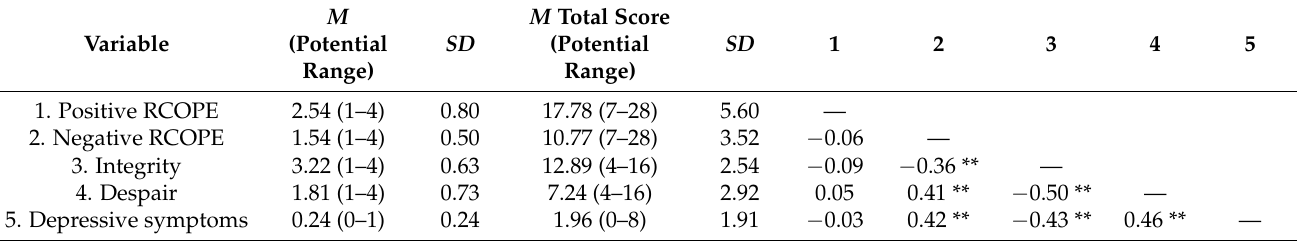
Table 1. Descriptive statistics and correlations for main study